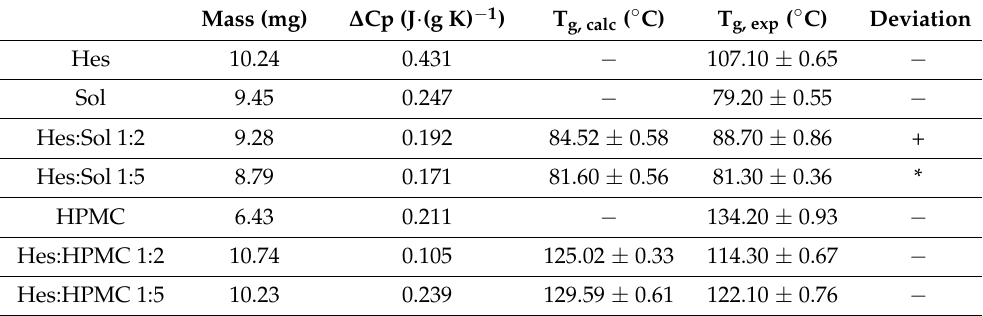
Figure 2. The differential scanning calorimetry (DSC) analysis-second heating: ( a ) Hesperidin (Hes), Soluplus ® (Sol), Hes:Sol 1:2 w/w system, Hes:Sol 1:5 w/w system; ( b ) Hesperidin, alginate sodium (SA), Hes:SA 1:2 w/w system, Hes:SA 1:5 w/w system; ( c ) Hesperidin, hydroxypropylmethylcellulose (HPMC), Hes:HPMC 1:2 w/w system, Hes:HPMC 1:5 w/w system. Table 1. Summary of the most important parameters of thermal analysis of Hes: carrier systems.